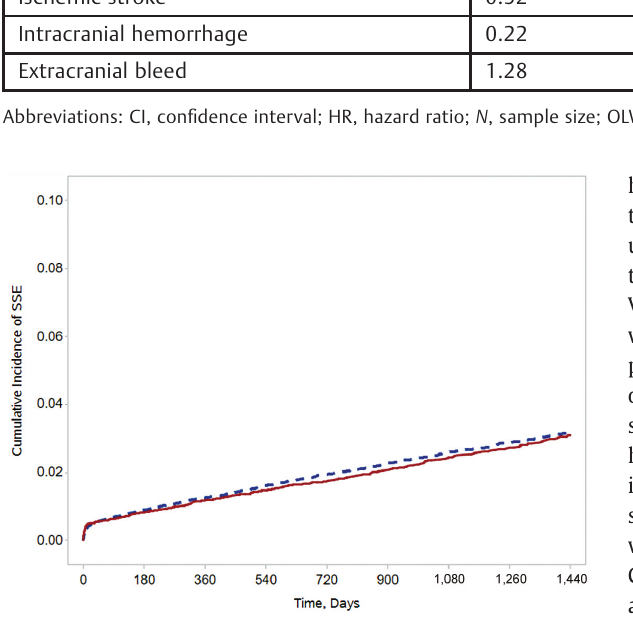
Fig. 2 Kaplan – Meier curve for stroke or systemic embolism. Red/solid line represents rivaroxaban; blue/dashed line represents warfarin.